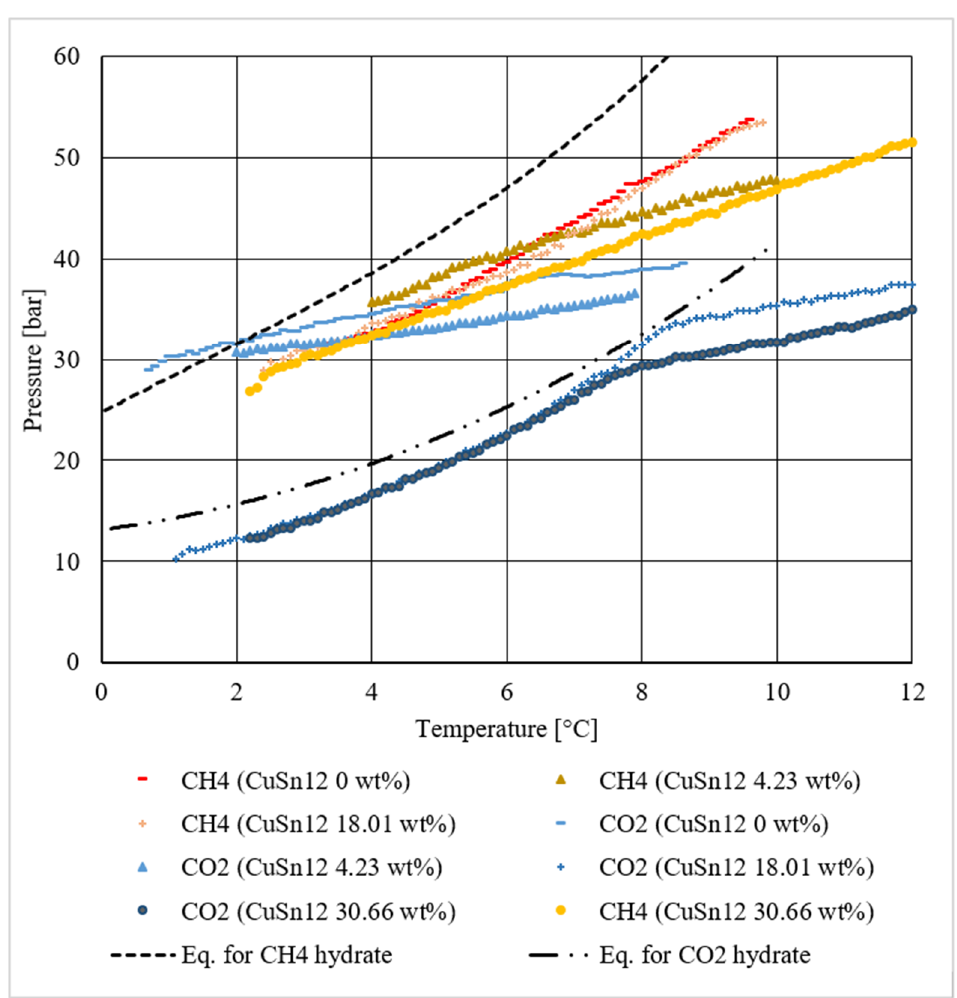
Figure 22. Hydrate dissociation conditions measured during all tests and compared among each other.